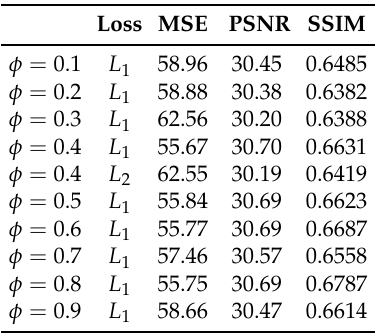
Table 1. Parameter of global loss